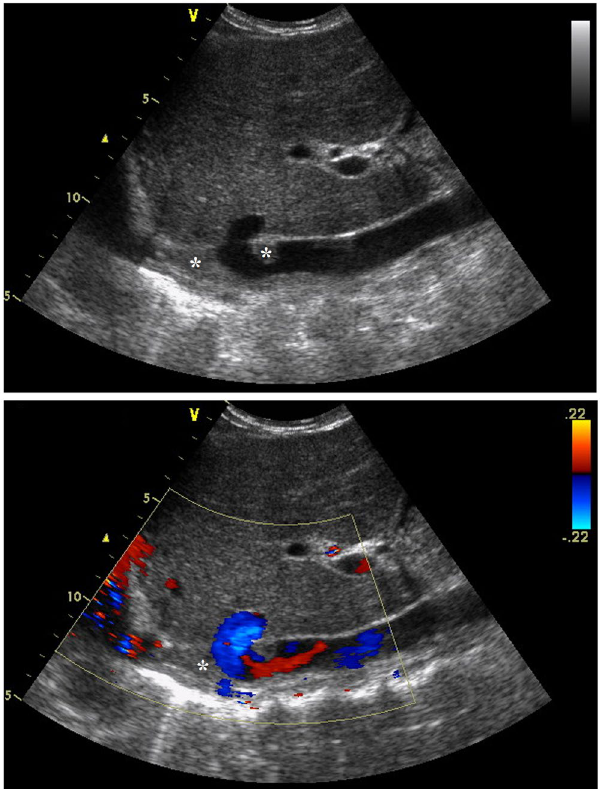
Figure 2. Preoperative color Doppler sonography. Segmental occlusion, thrombus and a small amount of blood flow echoes were shown in IVC. * indicated thrombus.